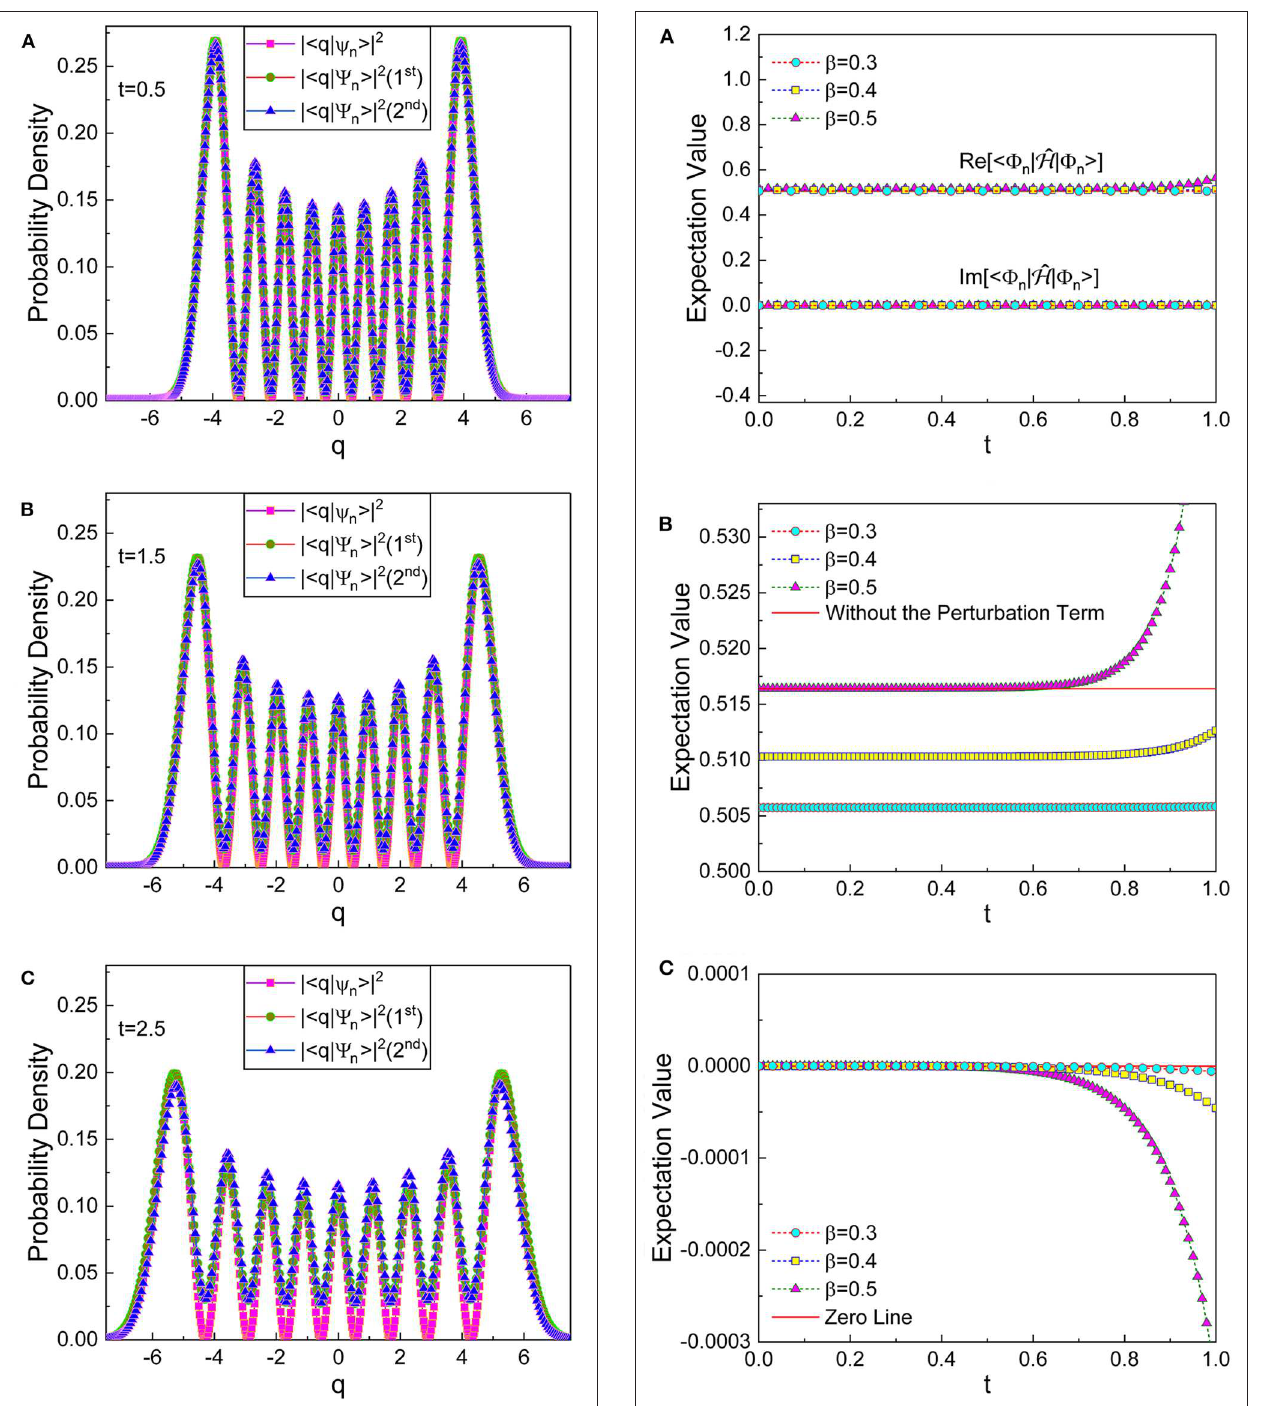
Frontiers in Physics | www.frontiersin.org